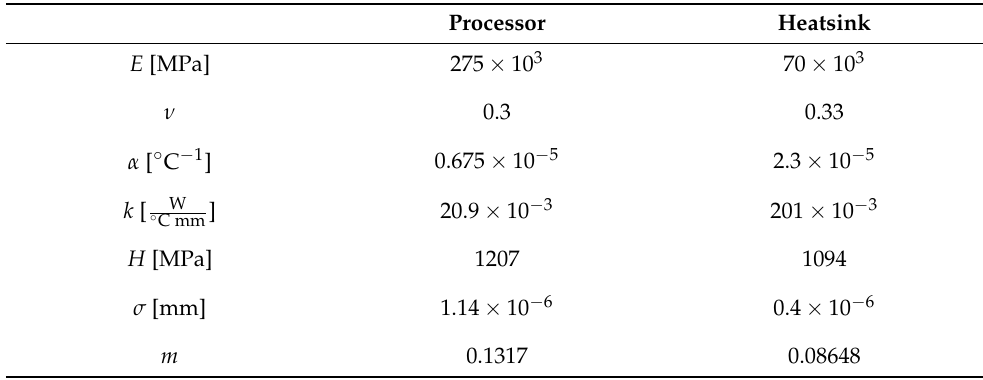
Table 3. Material properties of the microelectronic